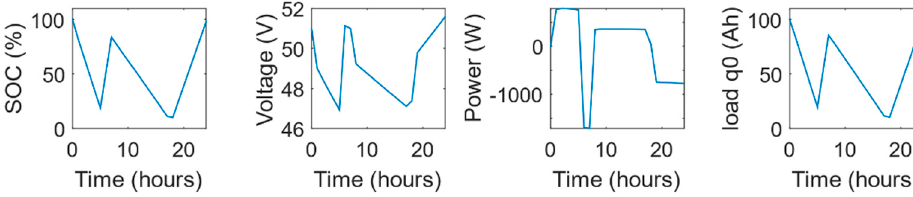
Figure 15. BESS parameters.